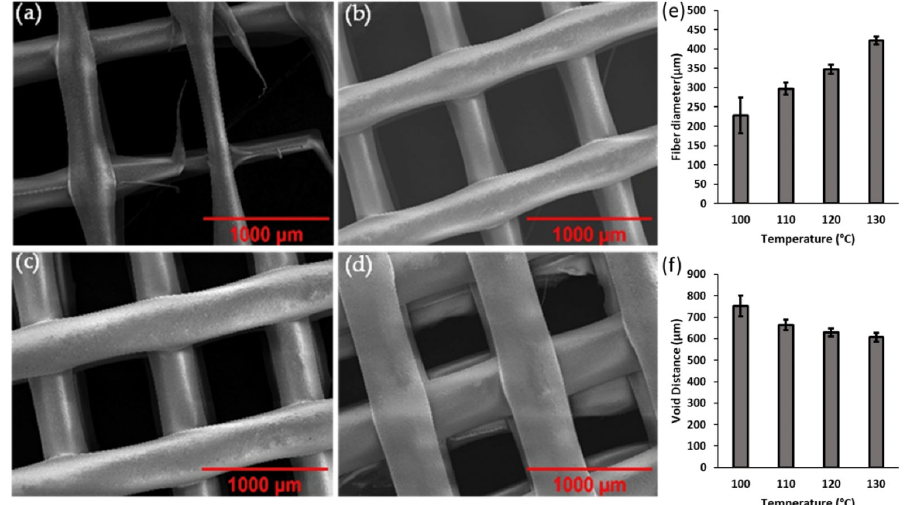
Figure 1. SEM images of 3D ‐ printed PCL at ( a ) 100 °C, ( b ) 110 °C, ( c ) 120 °C and ( d ) 130 °C. Distribution of average size for ( e ) fiber diameter and ( f ) void distance at various temperatures.